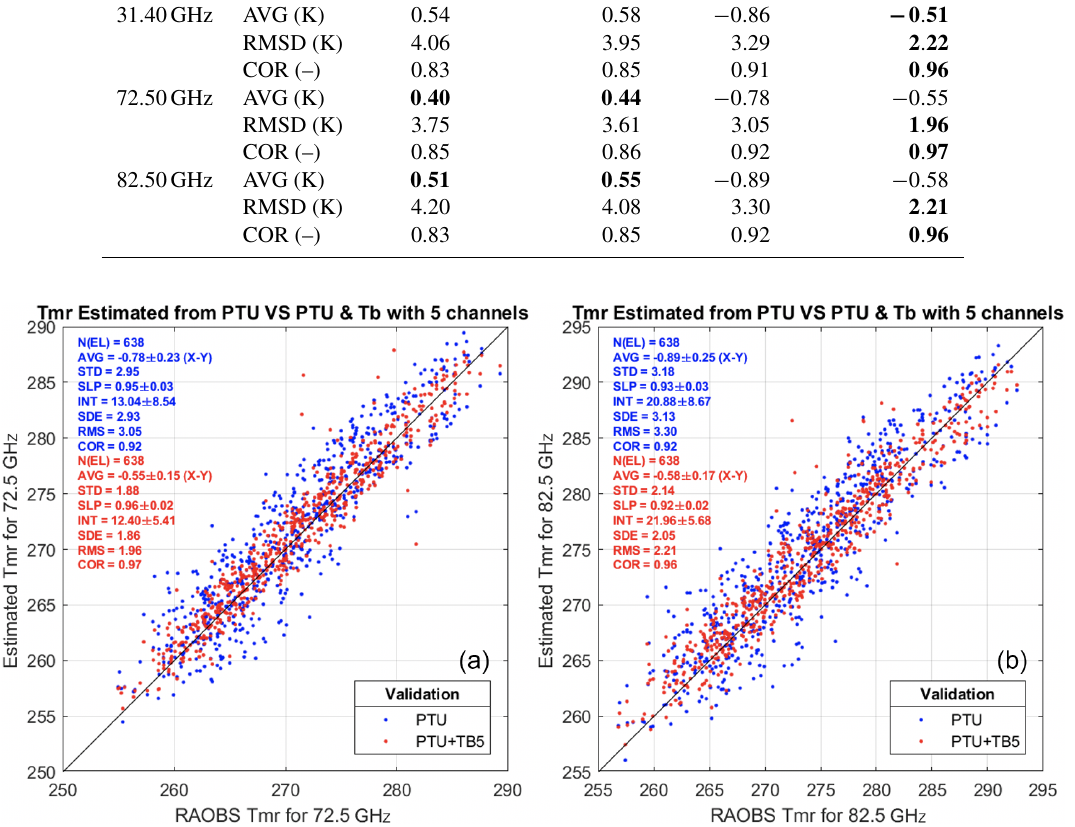
Figure 4. As in Fig. 3 but for V- and W-band channels: (a) 72.5GHz and (b) 82.5GHz. Table 2. Percentage improvements brought by the proposed method (based on PTU and T B ) over the conventional method (based on PTU only). Note that while the improvements for T MR are validated against radiosondes (i.e., the SD in Figs. 3–4), the improvements for A are estimated through Eqs. (5)–(6) and thus represent an estimate of the expected